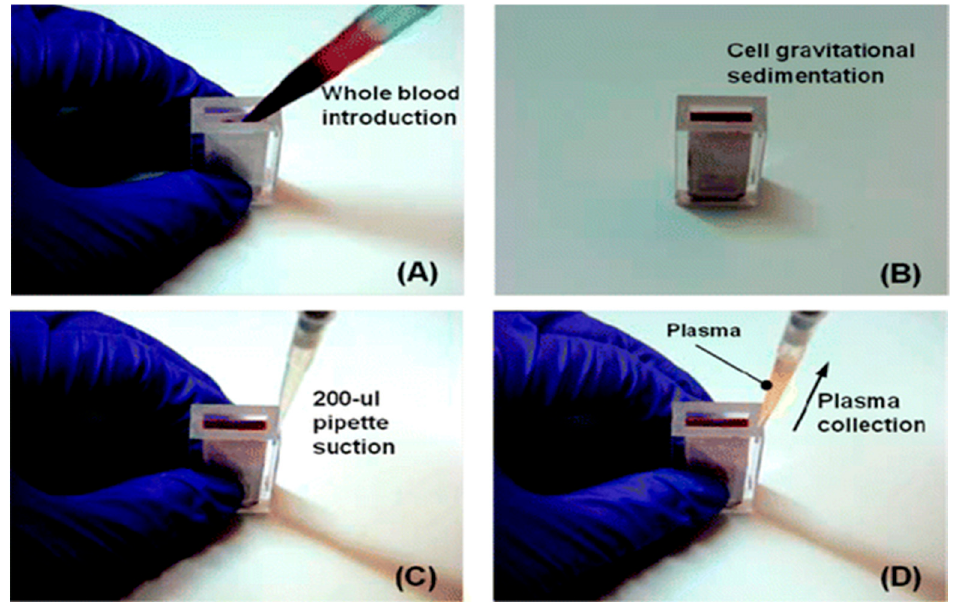
Figure 12. Operation of plasma extraction module. ( A ) Introduction of a 1.8-mL whole blood sample, ( B ) wait 10-min for cell sedimentation, ( C , D ), extract 200 µ L of plasma. From [164].